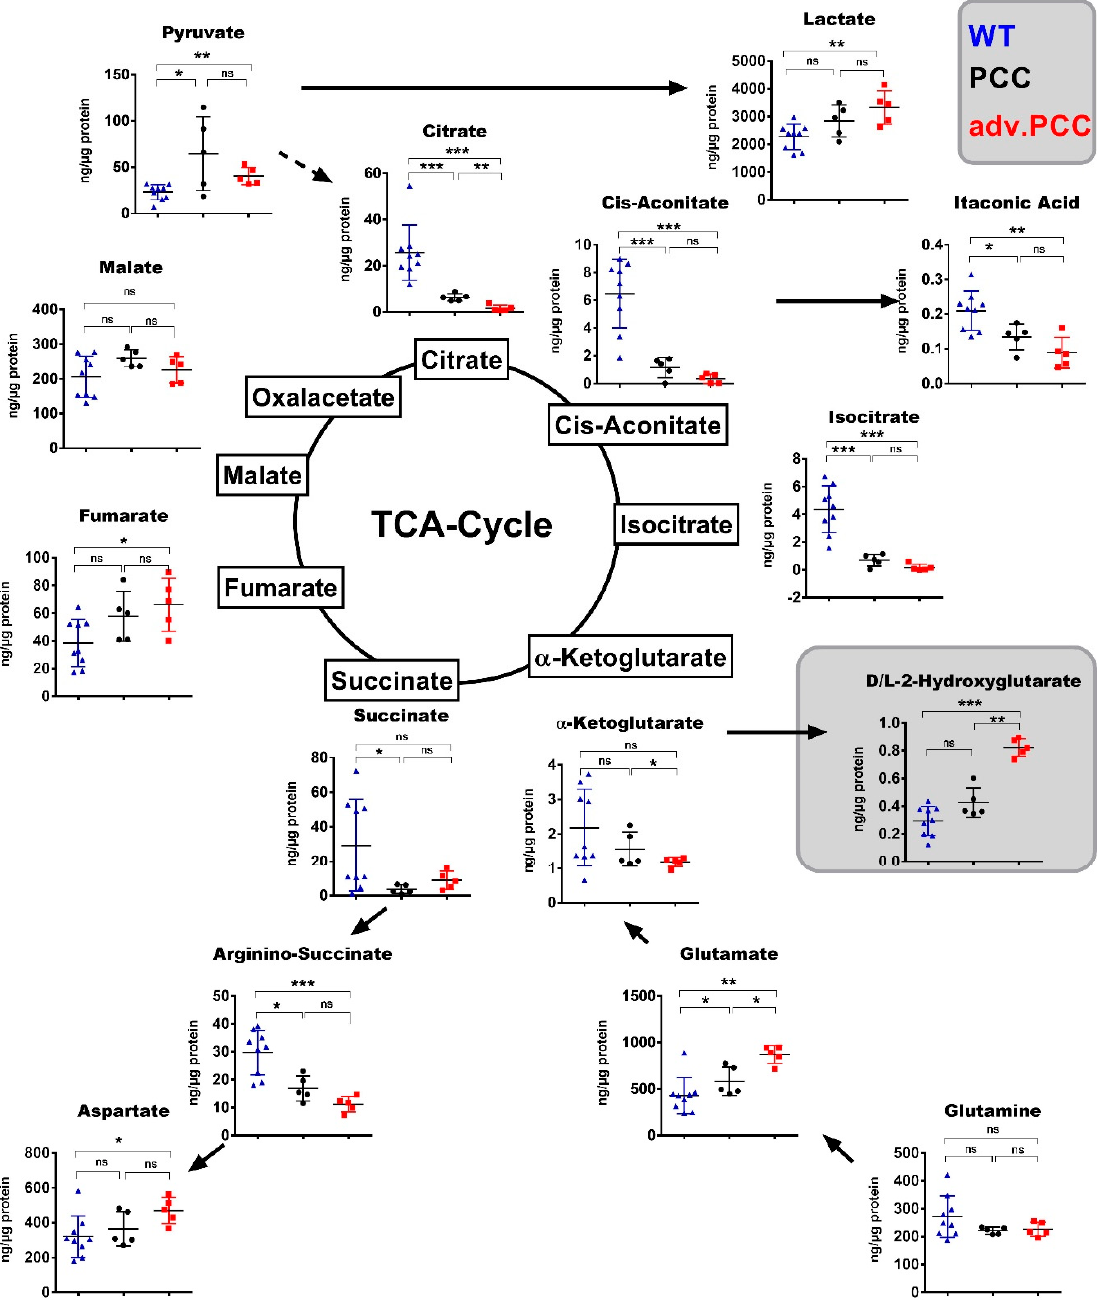
Figure 3. Targeted metabolomics of TCA-cycle metabolites in MENX PCCs. Metabolomic analysis of TCA-cycle metabolites in the adrenal medulla of WT (n = 9), PCC (n = 5) and adv. PCC (n = 5) at 7–9 months of age was done by LC–MS/MS. Measurements are reported as ng/g of total protein. Each symbol represents one animal: blue triangle = WT; black dot = PCC; red square = adv. PCC. Data are expressed as the mean ± SD. p -values were calculated by the Mann–Whitney test. (*** p < 0.001, ** p < 0.01, * p <0.05, ns p > = 0.05.